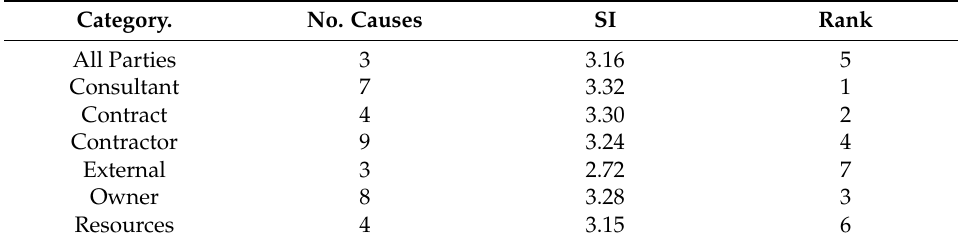
Table 5. Significance index and ranking of